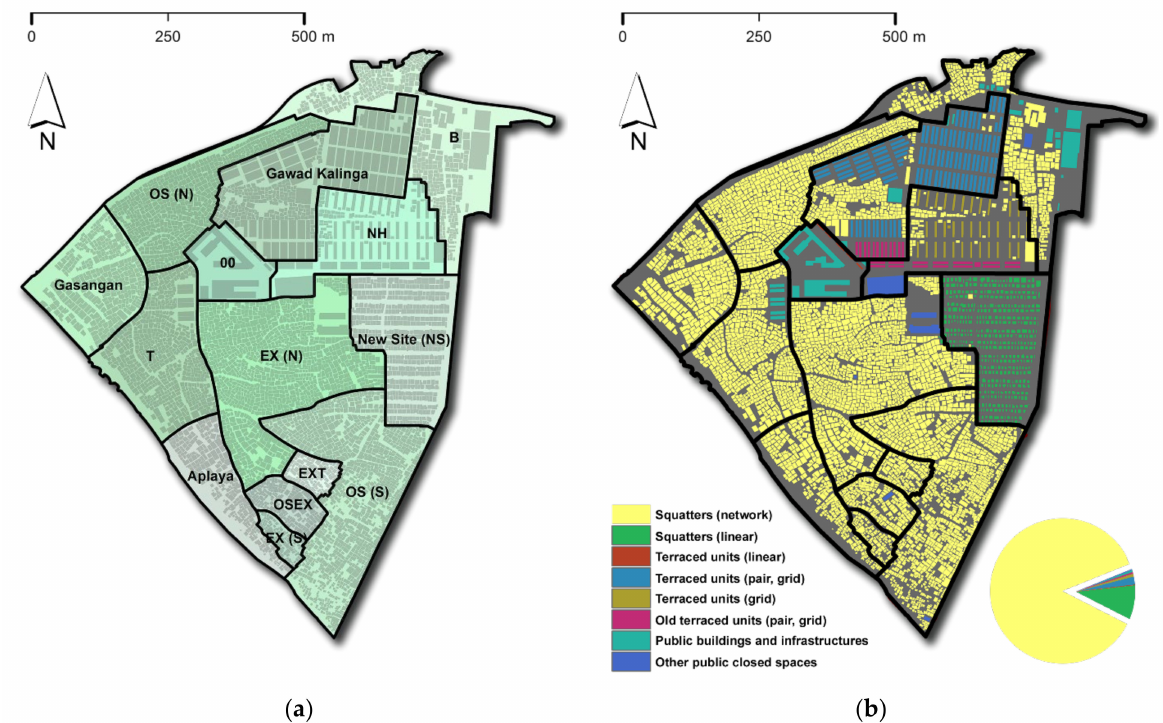
Figure 7. Qualitative analysis of BaSECo: ( a ) urban districts; ( b ) building types. The pie chart on the right side highlights the dominance of squatters over the other building types.